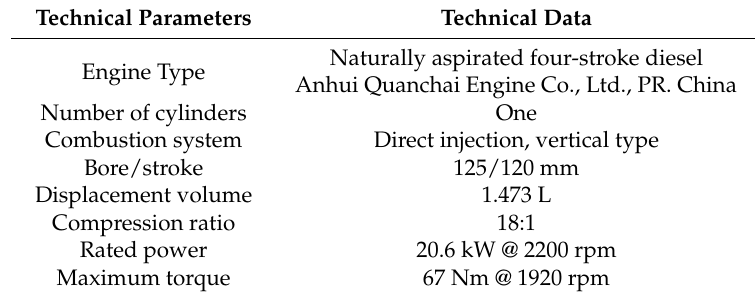
Table 1. Specification of the test engine [33].